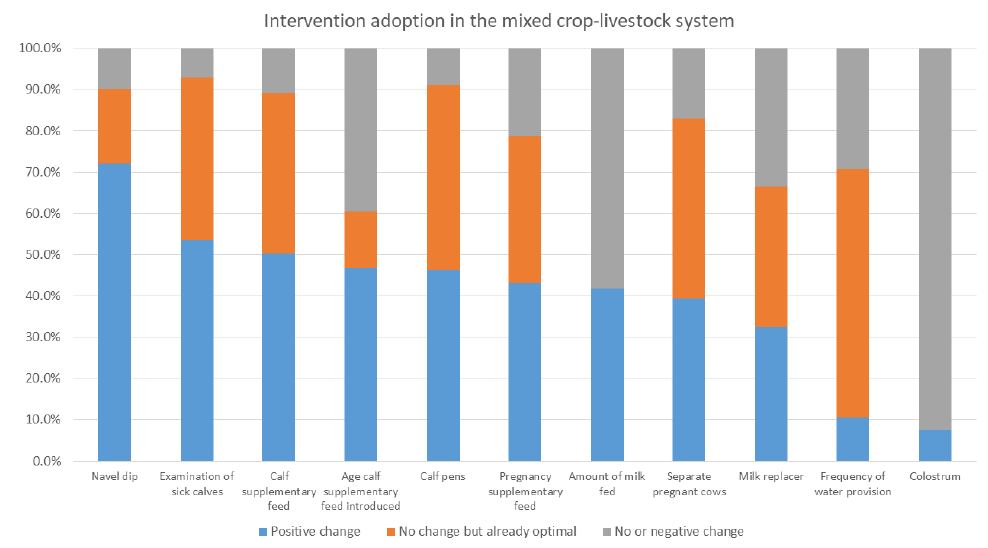
Figure 3. The proportion of enrolled mixed crop–livestock households with baseline and final evaluation data with either (a) no change in intervention area practices during the study period but were already optimal at the start of the study, (b) positive change, or (c) no or negative change in intervention areas.